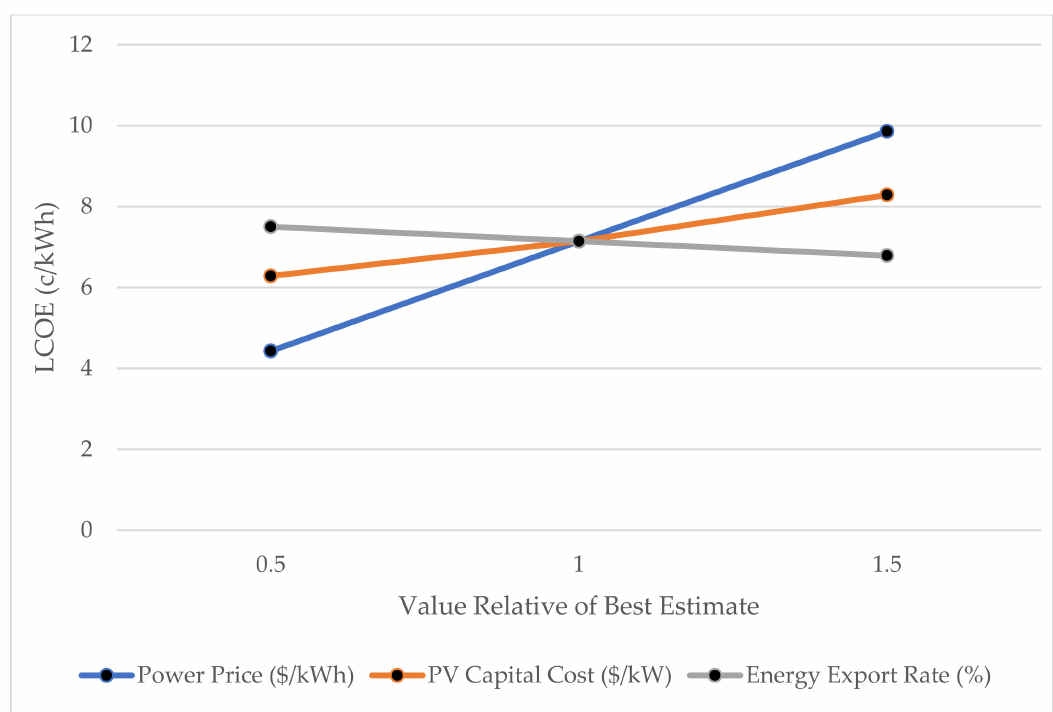
Figure 19. Sensitivity Analysis of PV On-grid Scenario